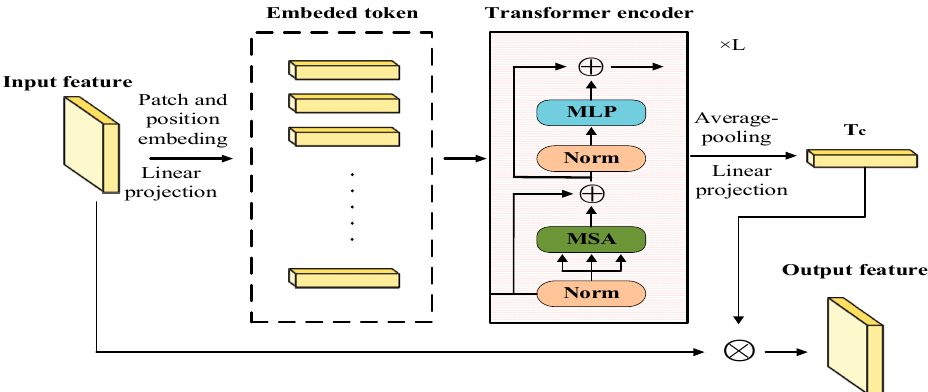
Figure 2. Architecture of the proposed Transformer-based channel attention module (TCAM).